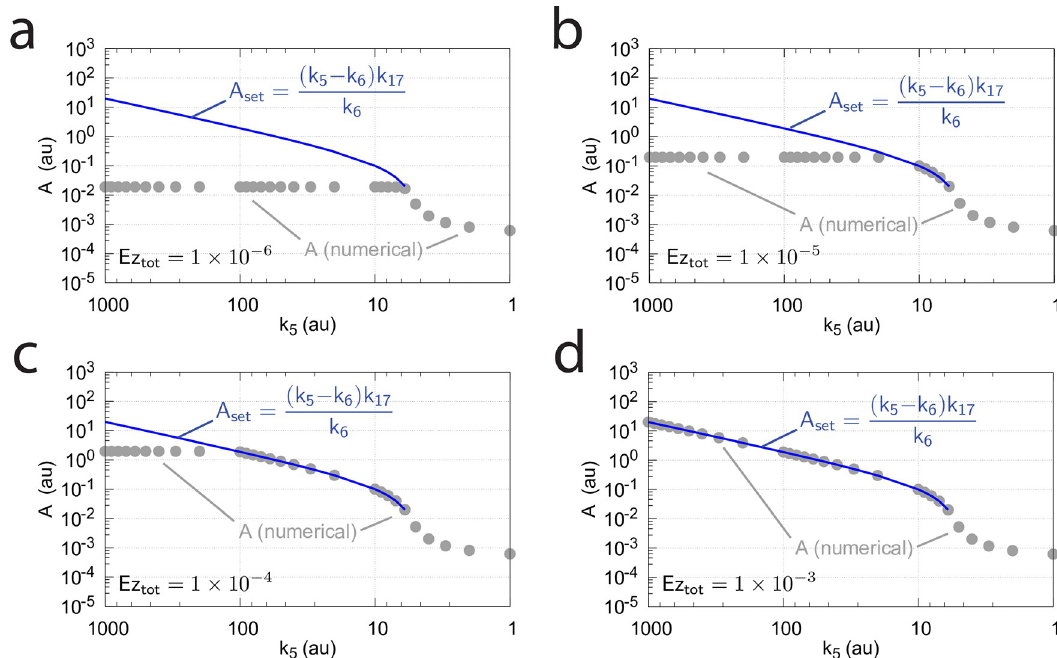
Fig 55. Influence of total enzyme concentration Ez tot on the performance of the system in Fig 54c. (a) Ez tot =1.0 × 10 − 6 ; (b) Ez tot =1.0 × 10 − 5 ; (c) Ez tot =1.0 × 10 − 4 ; (d) Ez tot =1.0 × 10 − 3 . Rate constant values as for Fig 54c. Initial concentrations: (a) A 0 =3.000, E 1,0 =1.01 × 10 − 2 , E 2,0 =3.333, Ez 0 =1 × 10 − 6 , (E 1 � Ez) 0 =0.0, (E 1 � Ez � E 2 ) 0 =0.0, (EzE 2 ) 0 =0.0. (b) A 0 =3.000, E 1,0 =1.01 × 10 − 2 , E 2,0 =3.333, Ez 0 =1 × 10 − 5 , (E 1 � Ez) 0 =0.0, (E 1 � Ez � E 2 ) 0 =0.0, (EzE 2 ) 0 =0.0. (c) A 0 =3.000, E 1,0 =1.01 × 10 − 2 , E 2,0 =3.333, Ez 0 =1 × 10 − 4 , (E 1 � Ez) 0 =0.0,